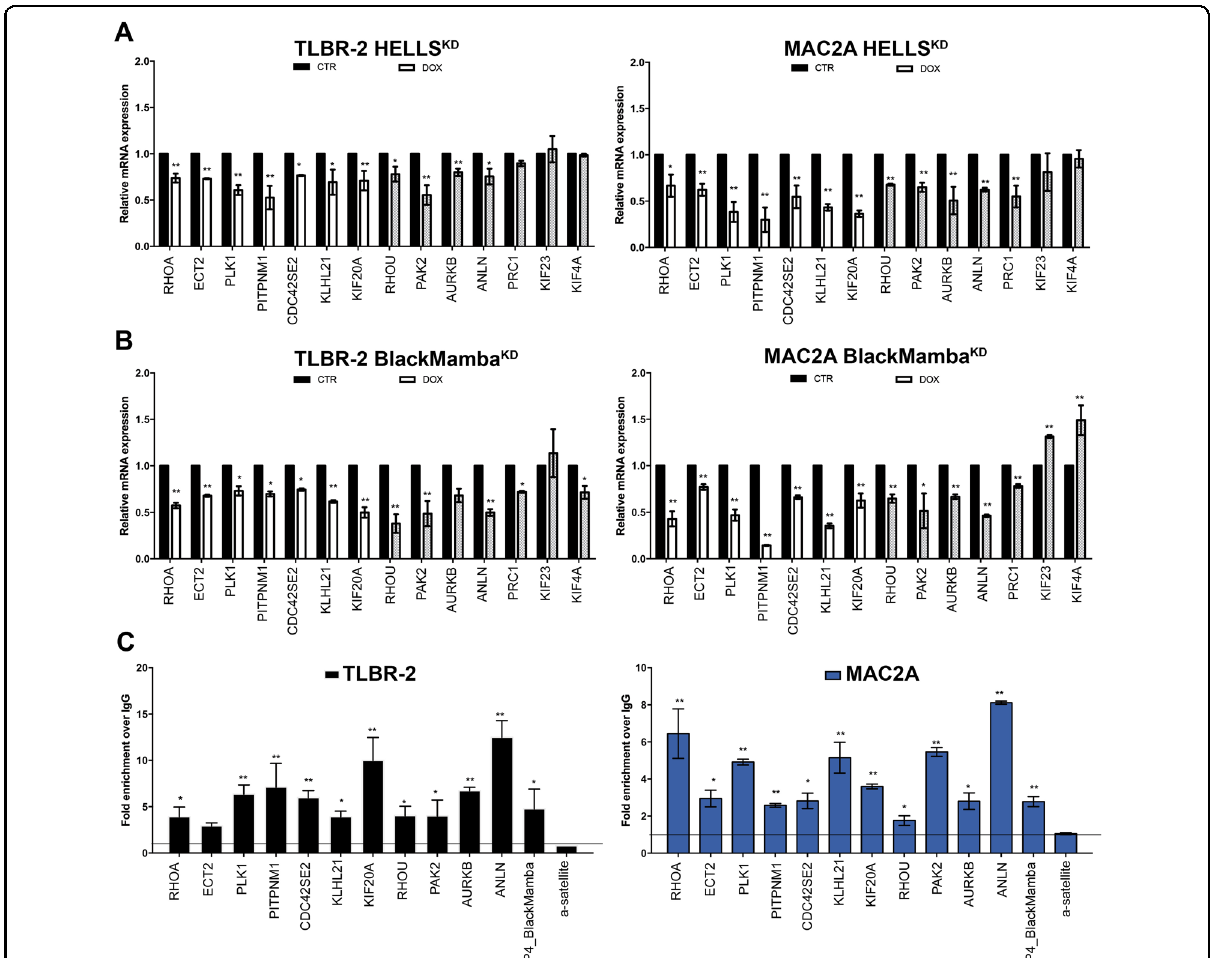
Fig. 2 HELLS binds target gene promoters. A qRT-PCR validation of signi fi cantly downregulated genes obtained from RNA-sequencing. White bars represent the most signi fi cantly downregulated genes (FDR < 0.1) and gray bars represent less signi fi cant downregulated genes (FDR > 0.1) in TLBR-2 HELLS KD cells and MAC2A HELLS KD cells after 48 h of doxycycline (DOX) induction. Each data represent mean ± SEM ( n = 3). Two-tailed t -test. * p < 0.05; ** p < 0.01. B qRT-PCR validation of signi fi cantly downregulated genes obtained from RNA-sequencing. White bars represent the most signi fi cantly downregulated genes (FDR < 0.1) and gray bars represent less signi fi cant downregulated genes (FDR > 0.1) in TLBR-2 BlackMamba KD cells and MAC2A BlackMamba KD cells after 6 days of doxycycline (DOX) induction. Each data represent mean ± SEM ( n = 3). Two-tailed t -test. * p < 0.05; ** p < 0.01. C ChIP qRT-PCR detection of HELLS antibody in a panel of target gene promoters in TLBR-2 and MAC2A.P4_BlackMamba and α -satellite were used as positive and negative controls, respectively. The values represent the relative fold enrichment over IgG and are indicated as mean ± SEM ( n = 3). Two-tailed t -test. * p < 0.05; ** p <